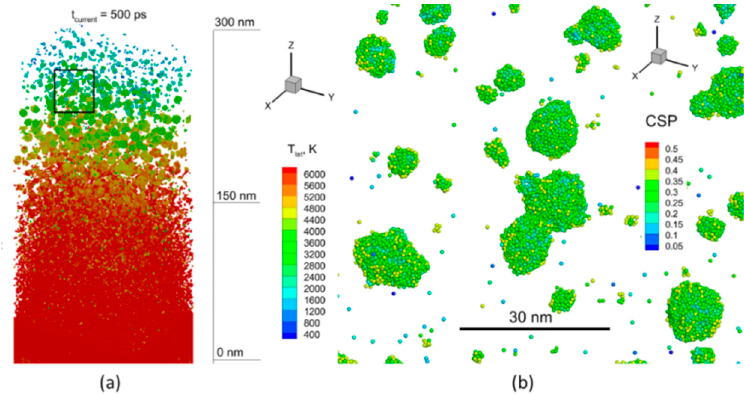
Figure 10. The zoomed region from Figure 9c allows for visualization of the top of ablation plume in the field of lattice temperature ( a ). The squared region is zoomed in ( b ) and represents the atomic view for examination of morphology of the forming Al NPs in water. The light blue atoms are indication of the onset of the solidification process. The water atoms are not shown.